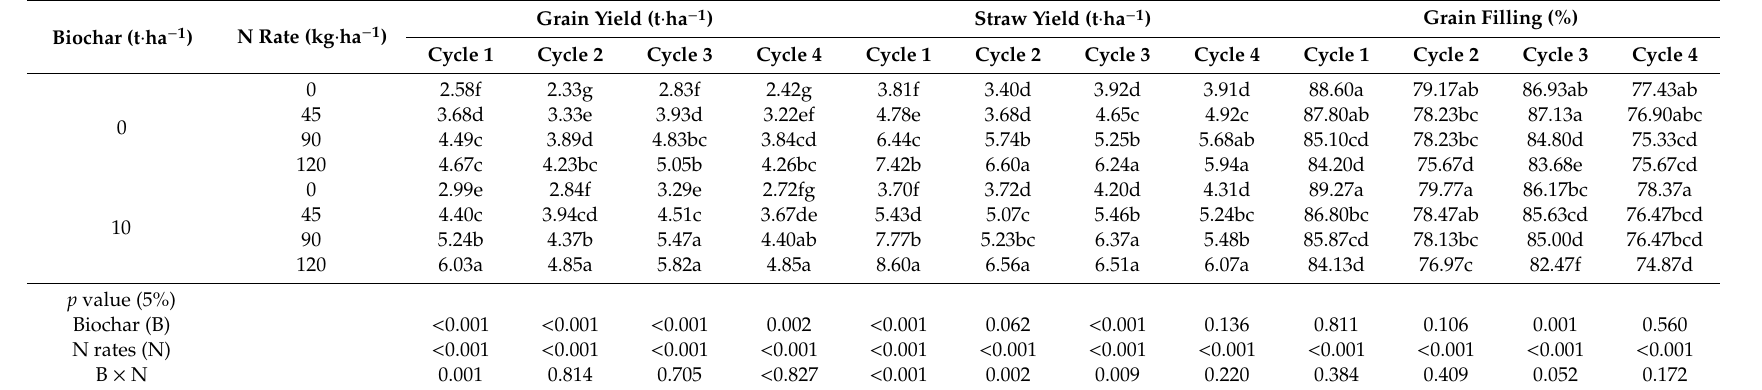
Table 6. E ff ect of soil amendment on grain and straw yield and proportion of grain filled of